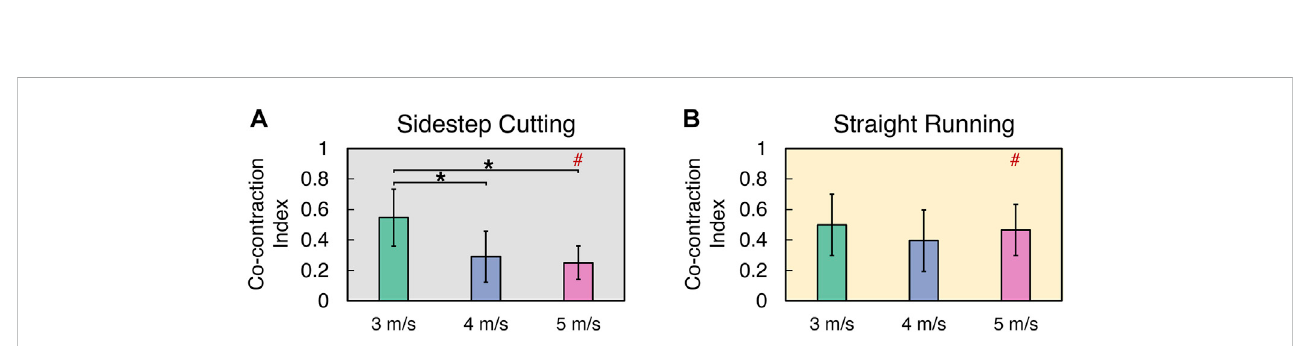
FIGURE 6 The mean and standard deviation of co-contraction index during (A) sidestep cutting ( Gray ) and (B) straight running ( Yellow ). Note: Signi fi cant differences between VELOCITIES denoted by asterisks (*) ( p < 0.05). Signi fi cant differences between running TYPES for each condition denoted by hash (#) ( p <